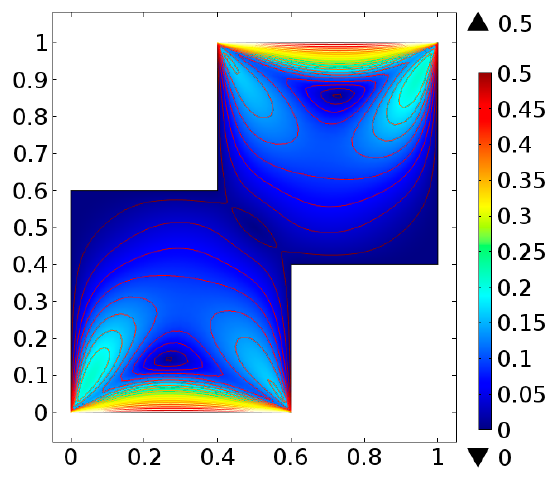
Figure 32. Velocity distribution at Re = 100 for case-III.